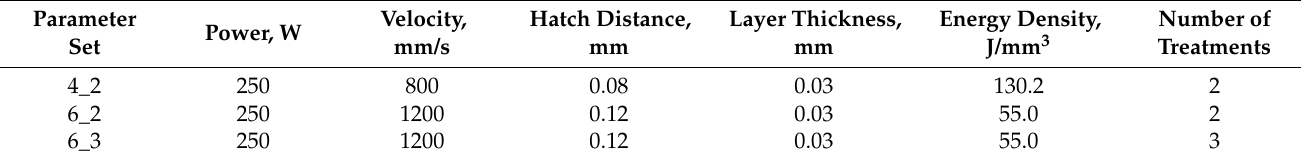
Table 3. Parameter sets used for double and triple laser